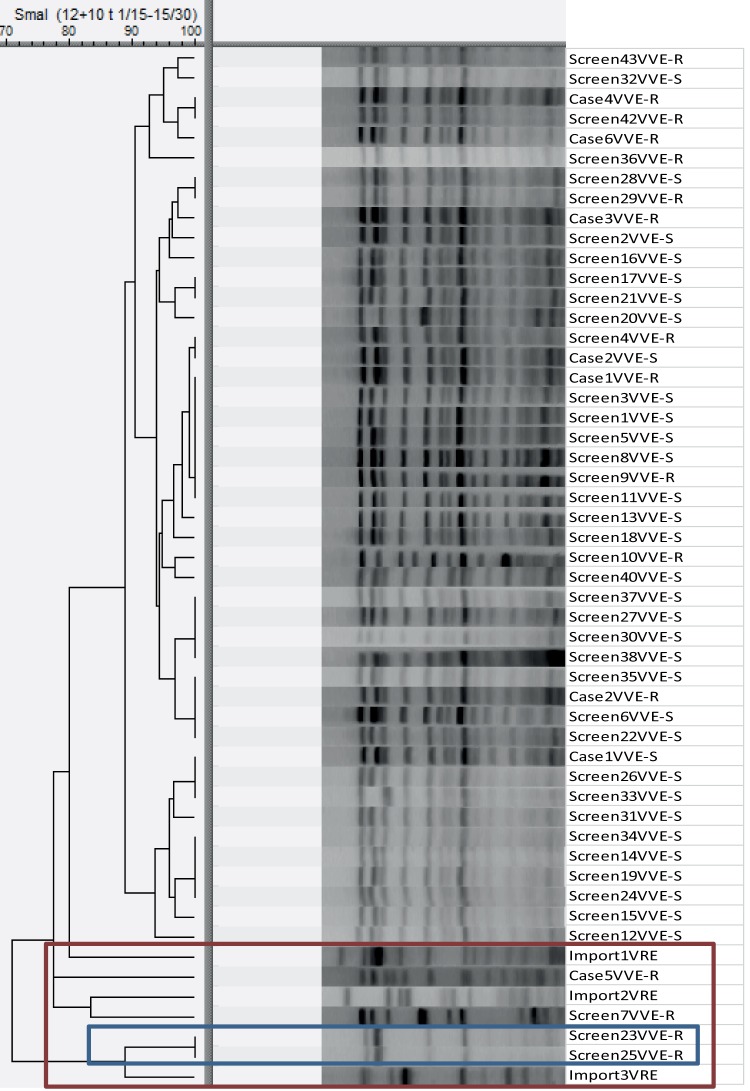
PFGE comparison of VVE E. faecium and VRE E. faecium isolated during this outbreak, with a UPGMA tree illustrating the distance between isolates. Inside the red box are pulsotypes of all isolates regarded unrelated to the main cluster. The blue box shows a local cluster of unrelated VVE within one single ward.